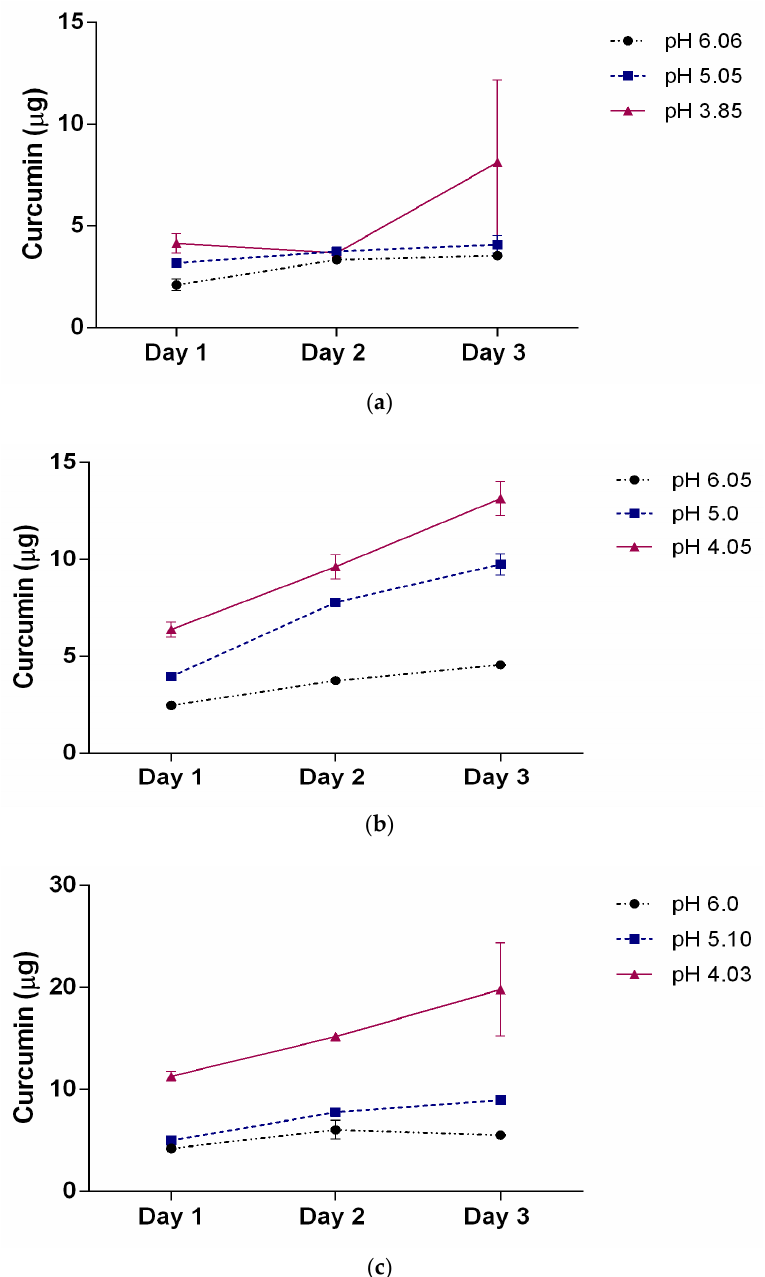
Figure 3. The release profile of curcumin as a function of pH over 3 days for three different SMA concentrations ( a ) 31.7 µ M; ( b ) 63.4 µ M, and ( c ) 111 µ M. The pH of the solutions was adjusted to approximately 6, 5, and 4. The data represent the mean ± SEM of triplicates.